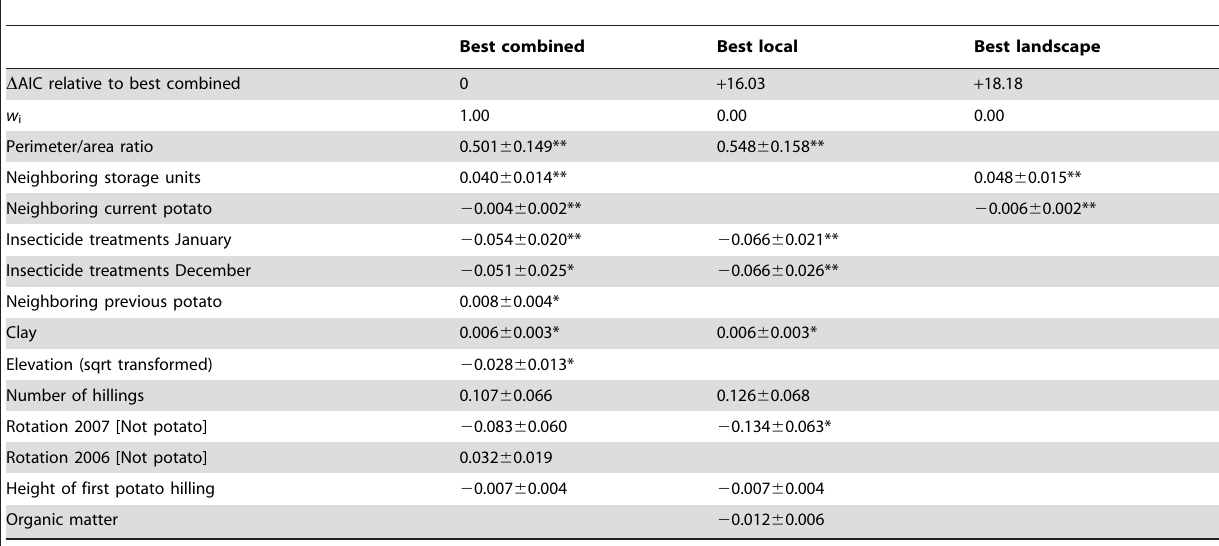
Best combined Best local Best landscape D AIC relative to best combined 0 + 16.03 +